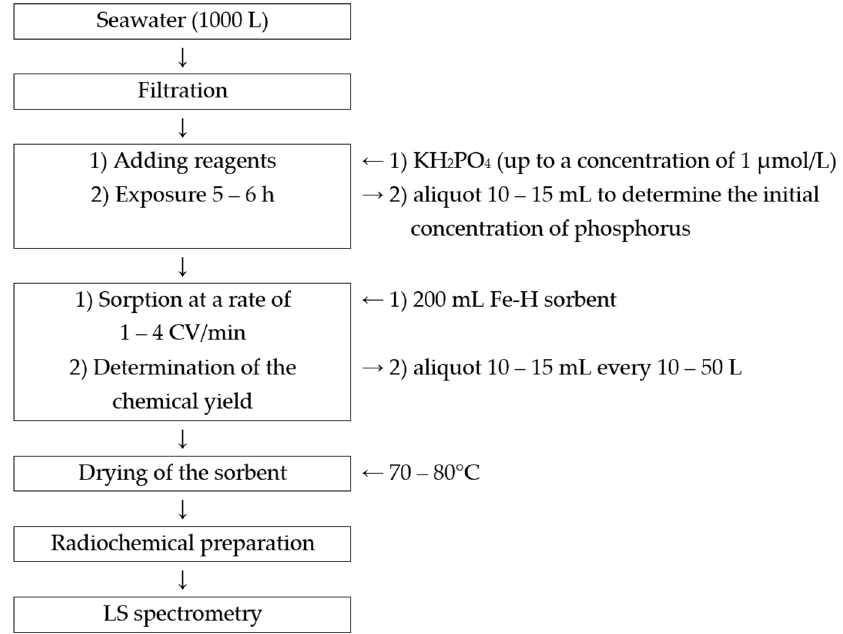
Figure 3. The developed methodology for 32 P and 33 P recovery from seawater.